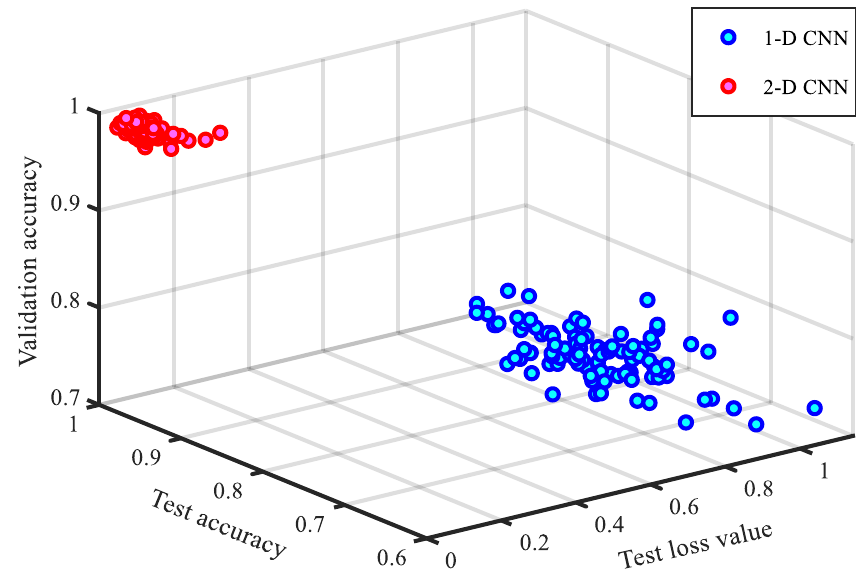
Figure 18. Performance comparison between 1-D CNN and 2-D CNN.